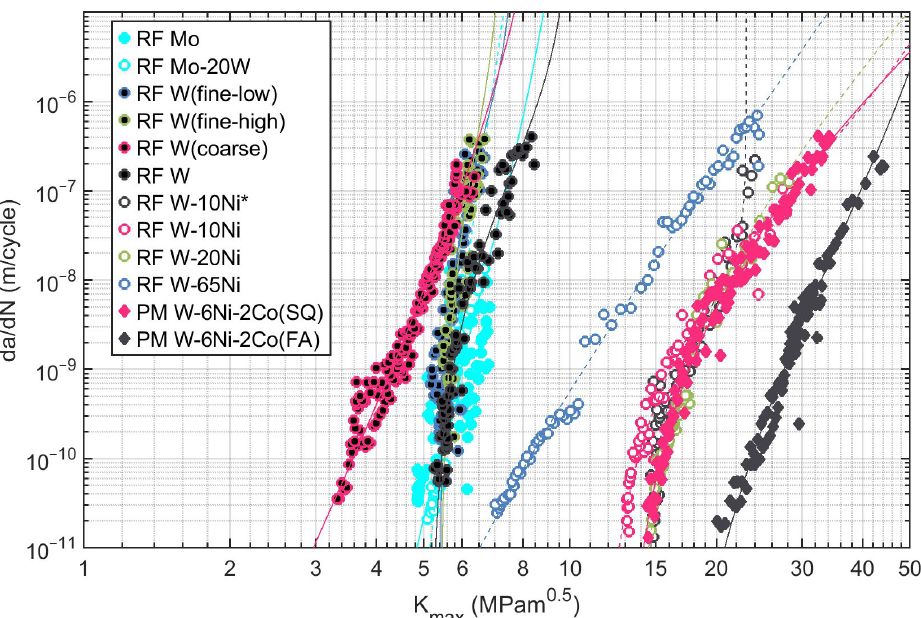
Figure 5. Fatigue crack growth data of the investigated refractory